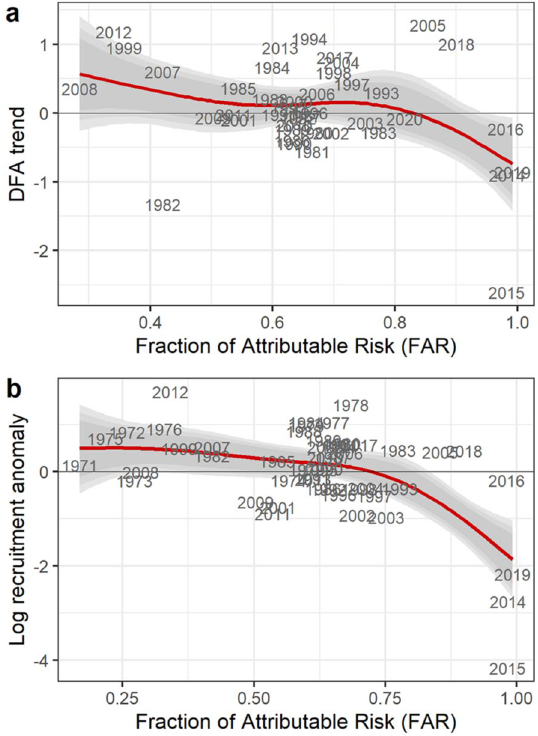
Figure 4. Anthropogenic temperature extremes and walleye pollock recruitment. ( a ) Dynamic Factor Analysis (DFA) shared trend of four field time series for age-0 recruitment as a function of FAR values for Gulf of Alaska sea surface temperature anomalies. ( b ) Estimated age-0 pollock recruitment from stock assessment model (1970–2019) as a function of FAR: predicted values and 80%/90%/95% CI. Recruitment log-transformed and scaled as zero mean, unit